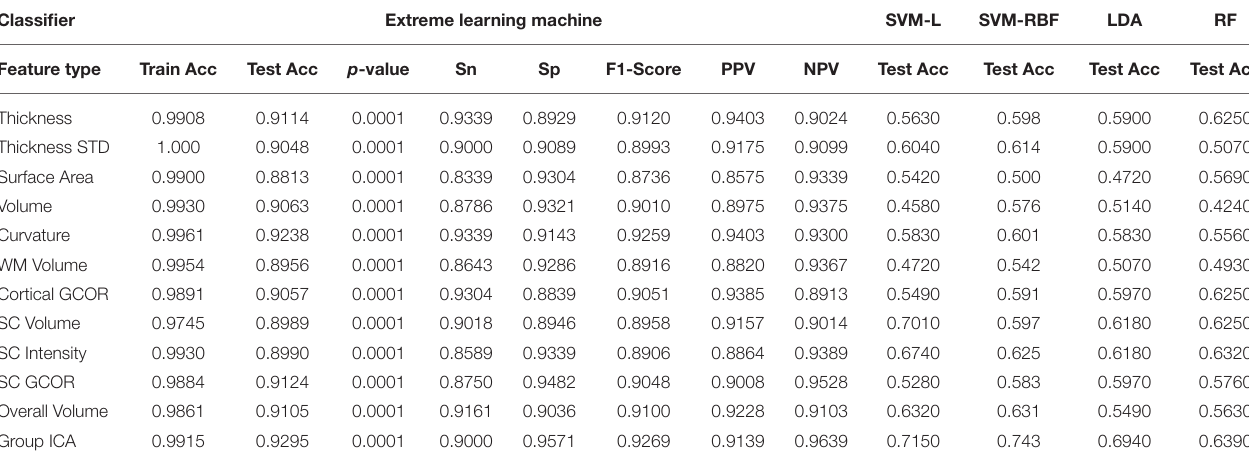
TABLE 5 | Mean classification results of each measure of the data from each modality. Classifier